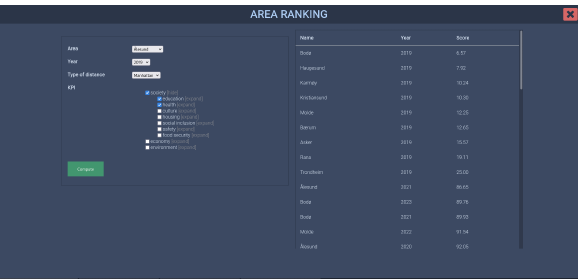
Figure 9. Screenshot with ranking